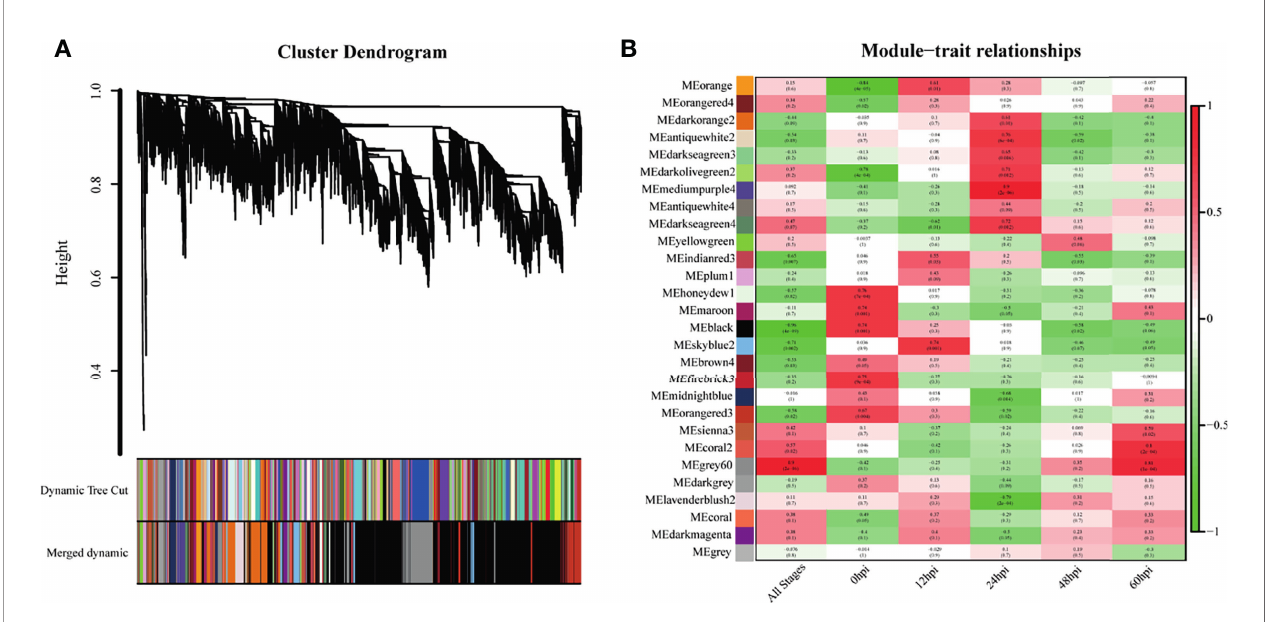
FIGURE 4 | Genes modules in weighted gene co-expression network analysis (WGCNA). (A) Hierarchical clustering tree (Cluster Dendrogram) indicates the co- expression modules identi fi ed by WGCNA at different infection stages. The branches correspond to modules of highly interconnected groups of genes. The height (y- axis) indicates the co-expression distance and the x-axis corresponds to genes. Colors represent the 28 different modules along with gray indicating genes that could not be assigned to any module. (B) A heatmap chart showing module-trait relationships. Red denotes a positive correlation and Blue indicates a negative correlation between the module and infection